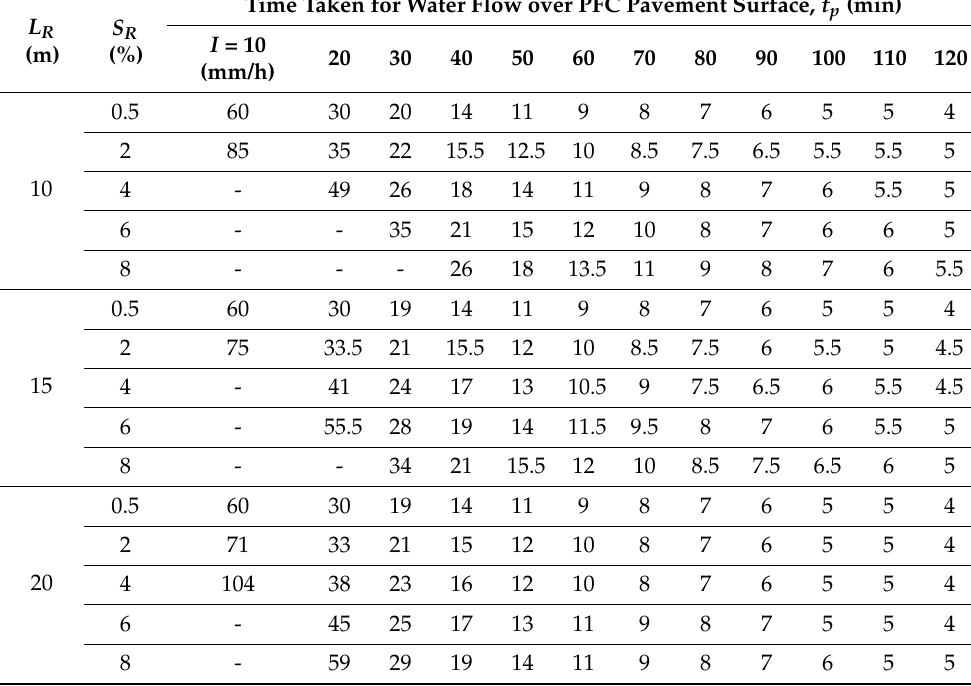
Table 3. Time taken for water flow over the PFC pavement surface ( t p